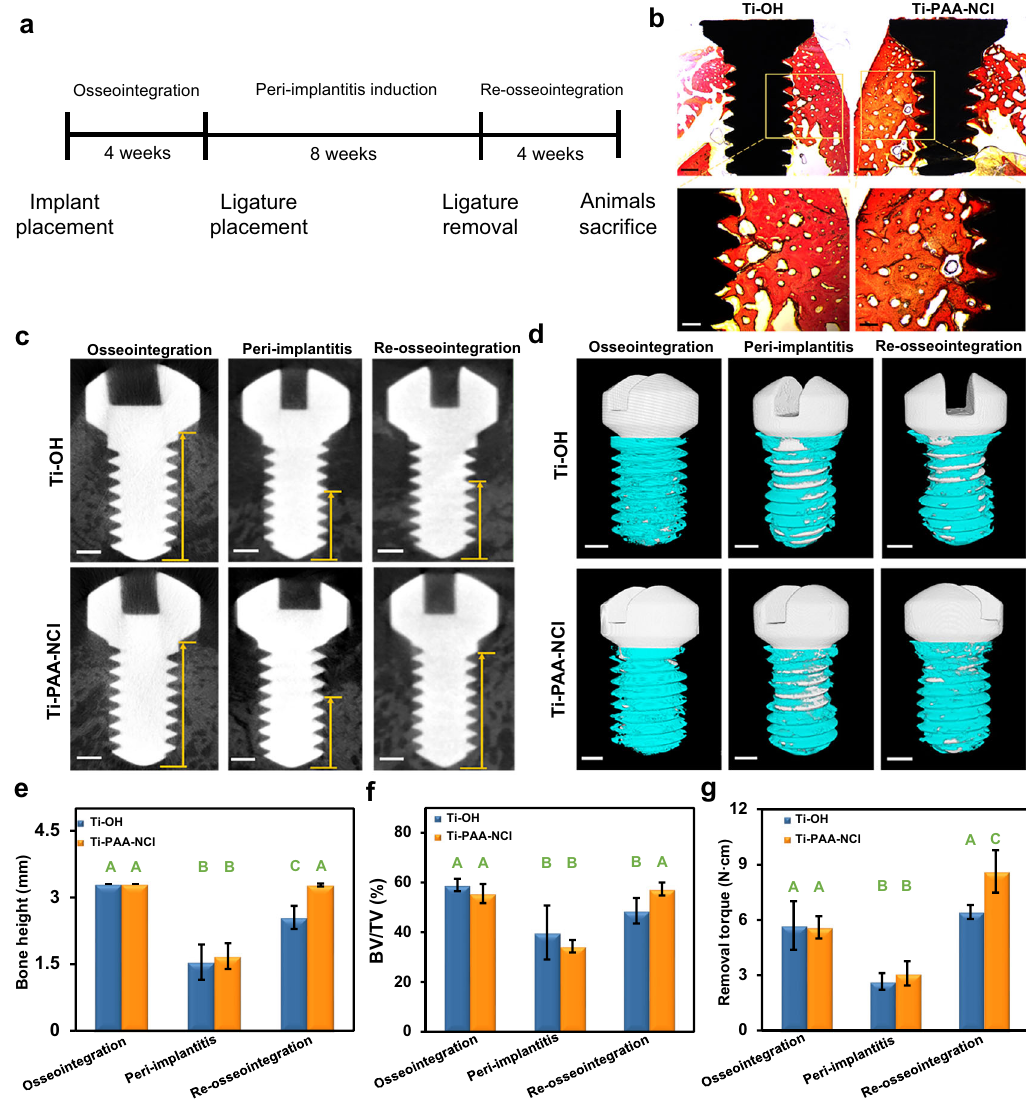
Fig. 6 In vivo assessments of osseointegration ability and effect against peri-implant infection. a Schematic timetable of experimental design. b Longitudinal sections of non-decalci fi ed specimens stained with Van Gieson ’ s staining after 4 weeks of implantation (upper scale bars = 500 µ m, lower scale bars = 250 µ m). c Micro-CT 2D image analysis illustrating the bone height surrounding the implants after osseointegration for 4 weeks, peri- implantitis for 8 weeks and re-osseointegration for 4 weeks (the length of yellow arrows represents the bone height referring to the vertical distance between the implant tip and the marginal bone level below the implant shoulder, scale bars = 500 µ m). d Micro-CT 3D reconstructions of the implants and surrounding bone tissues (white for the implant, cyan for bone tissues, scale bars = 500 µ m). e Height and f BV/TV of the bone surrounding implants, and g maximum removal torque of implants at all time points ( n = 3; different letters mean P < 0.05 for Ti-OH or Ti-PAA-NCl group among different time points and within each time point between groups; Wilcoxon nonparametric test or Student ’ s t test; error bars =